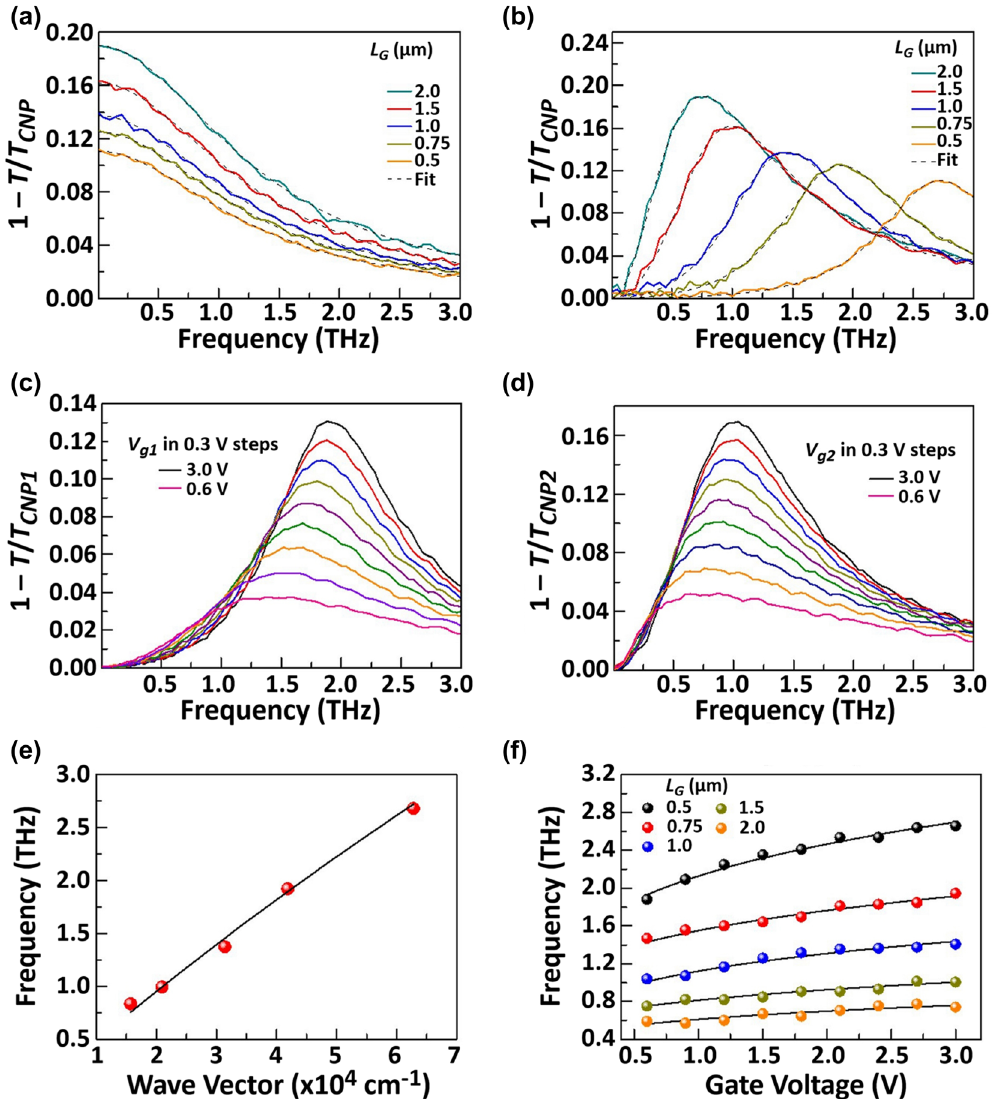
Figure 8: Gate-voltage- and length-dependent extinction spectra of the graphene structures for V d = 0 V. Plasmonic cavity length ( L G ) dependent extinction spectra of the three devices with incident light polarized parallel (a) and perpendicular (b) to the DGG fi ngers. The measured line shape is well reproduced by a Drude model fi t for parallel polarization (dashedline in (a)) and a damped oscillator model fi t for perpendicular polarization (dashed line in (b)). Measured gate voltage-dependent transmission spectra 1 − T / T CNP of the asymmetric device A-DGG1 with incident light polarized perpendicular to the DGG fi ngers, with biased cavities C1 when sweeping V g1 while the voltage on the other gateelectrodeis keptconstantat V g2 = V CNP2 (c) andbiasedcavities C2when sweeping V g2 whilethe voltageonthe othergate electrode is kept constant at V g1 = V CNP1 (d). Scaling laws of graphene plasmon resonance frequency in the three devices as a function of wave vector q = π / L G (e)andgatevoltage(f).Thesolidlinesin(e)and(f)are fi